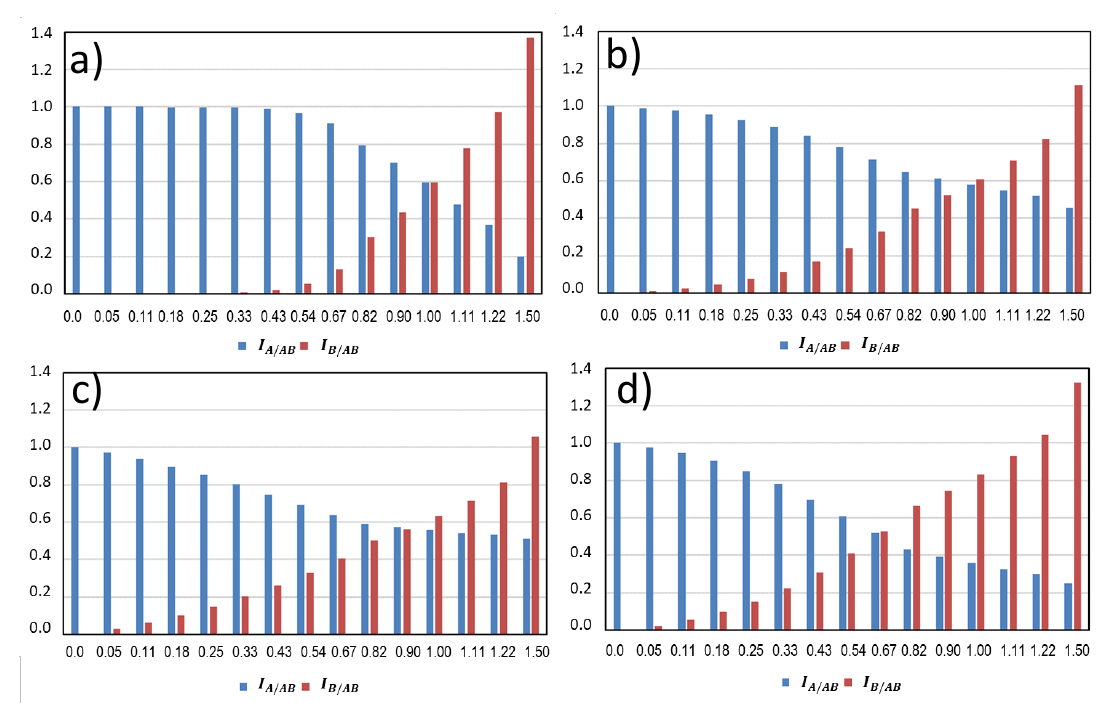
Figure 4. Modelled effects of the addition of increasing levels, in odour intensity units, of a second component (B—in red) on a solution containing a fixed amount of odour A—in blue ( I A = 1). The plots represent the odour intensities of the two component odours ( I A / AB and I B / AB ) in four situations differing in the steepness of the transition from one odour to the second (( a ) represents the steepest curves and sharpest transition, ( b ) the mean and ( c ) the flattest curves and transitions) or on the asymmetry ( d ). In this last case, the odour added is less dominant. The additivity of intensities follows in all cases a partial addition law.